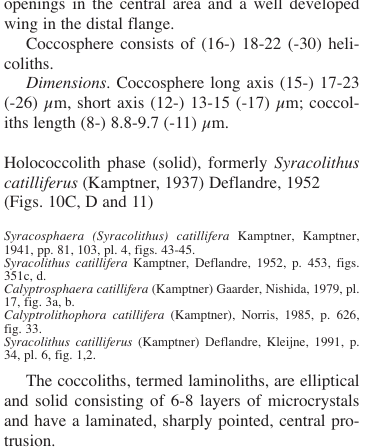
fig. 33. Syracolithus catilliferus (Kamptner) Deflandre, Kleijne, 1991, p. 34, pl. 6, fig. 1,2. The coccoliths, termed laminoliths, are elliptical and solid consisting of 6-8 layers of microcrystals and have a laminated, sharply pointed, central pro-